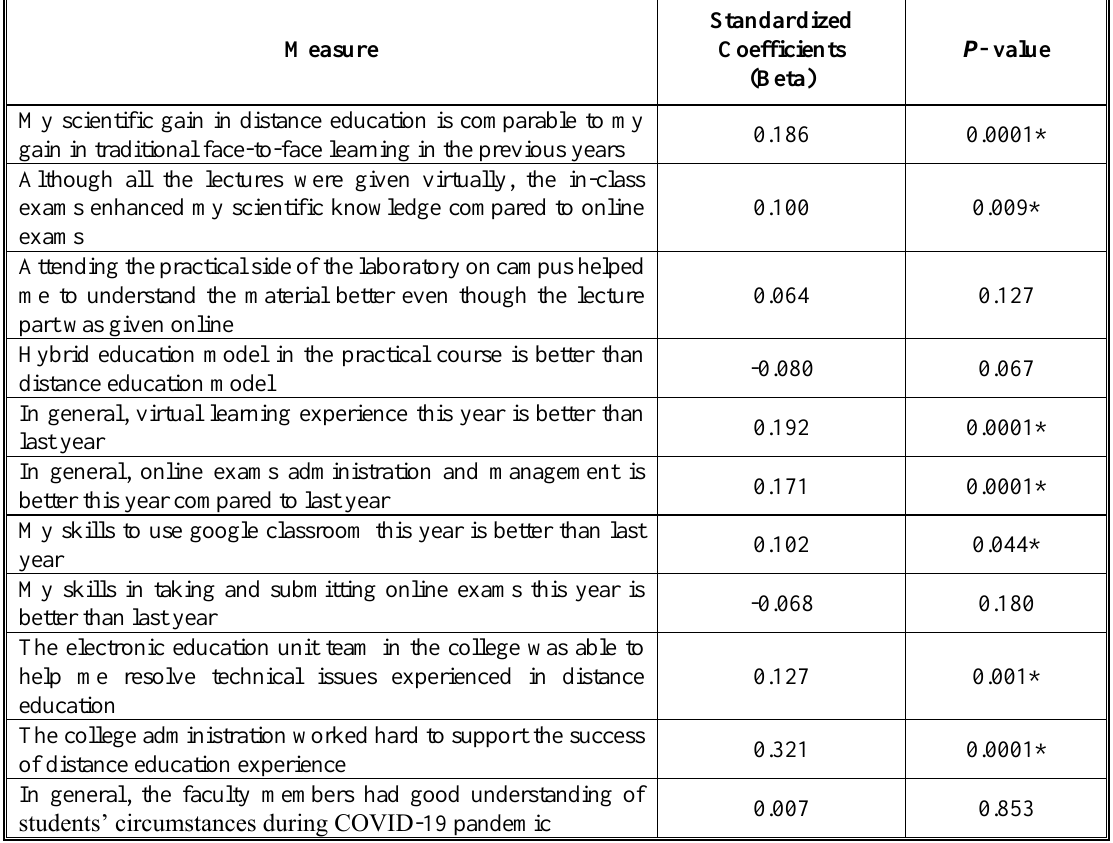
Table 2. Multiple linear regression of factors associated with student perceptions toward college hybrid education